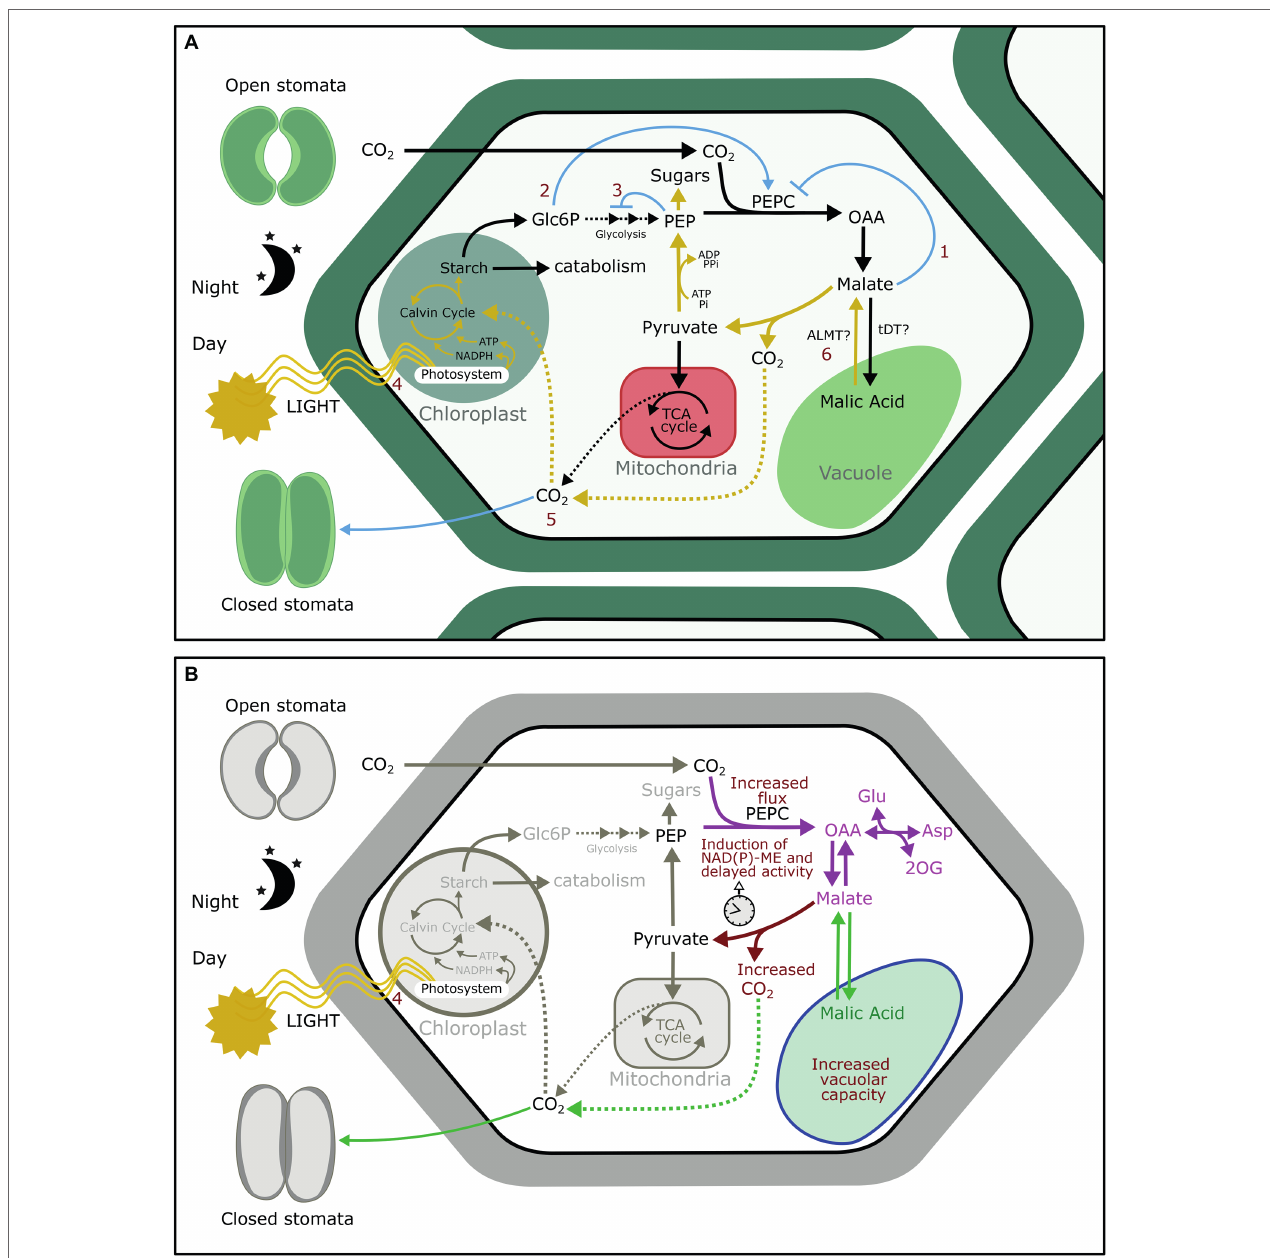
FIGURE 1 | (A) Regulatory interactions sufficient to give rise to diel oscillations of malate accumulation and CO 2 uptake adapted from Nungesser et al. (1984) skeleton model: malate inhibition of PEPC (1); Glc6P activation of PEPC (2); PEP inhibition of glycolysis (3); light activation of photosynthesis (4); induction of stomatal closure by high C i (5); and the autonomous vacuolar oscillator (6). (B) Pathways that articulated during CAM evolution. The anapleurotic fixation of CO 2 by PEPC in unicellular algae occurs to provide carbon skeletons for amino acid synthesis (magenta). The same pathway is found in C3 plants, which store in the vacuole malic acid resulting from CO 2 fixation during the night to be used for amino acid synthesis the next day. C3 plants are also able to close stomata upon high C i (green). Three events could have closed the cycle to give rise to CAM (brown): an increased flux through PEPC; an increase in decarboxylation activity, e.g., NAD(P)-ME, and its delay to not overlap with PEPC fixation; and finally, an increased vacuolar capacity that allows the concentration of CO 2 .